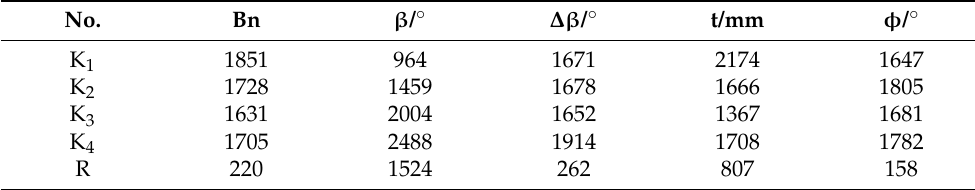
Table 7. Range analysis of MIX-130 fan pressure rise.